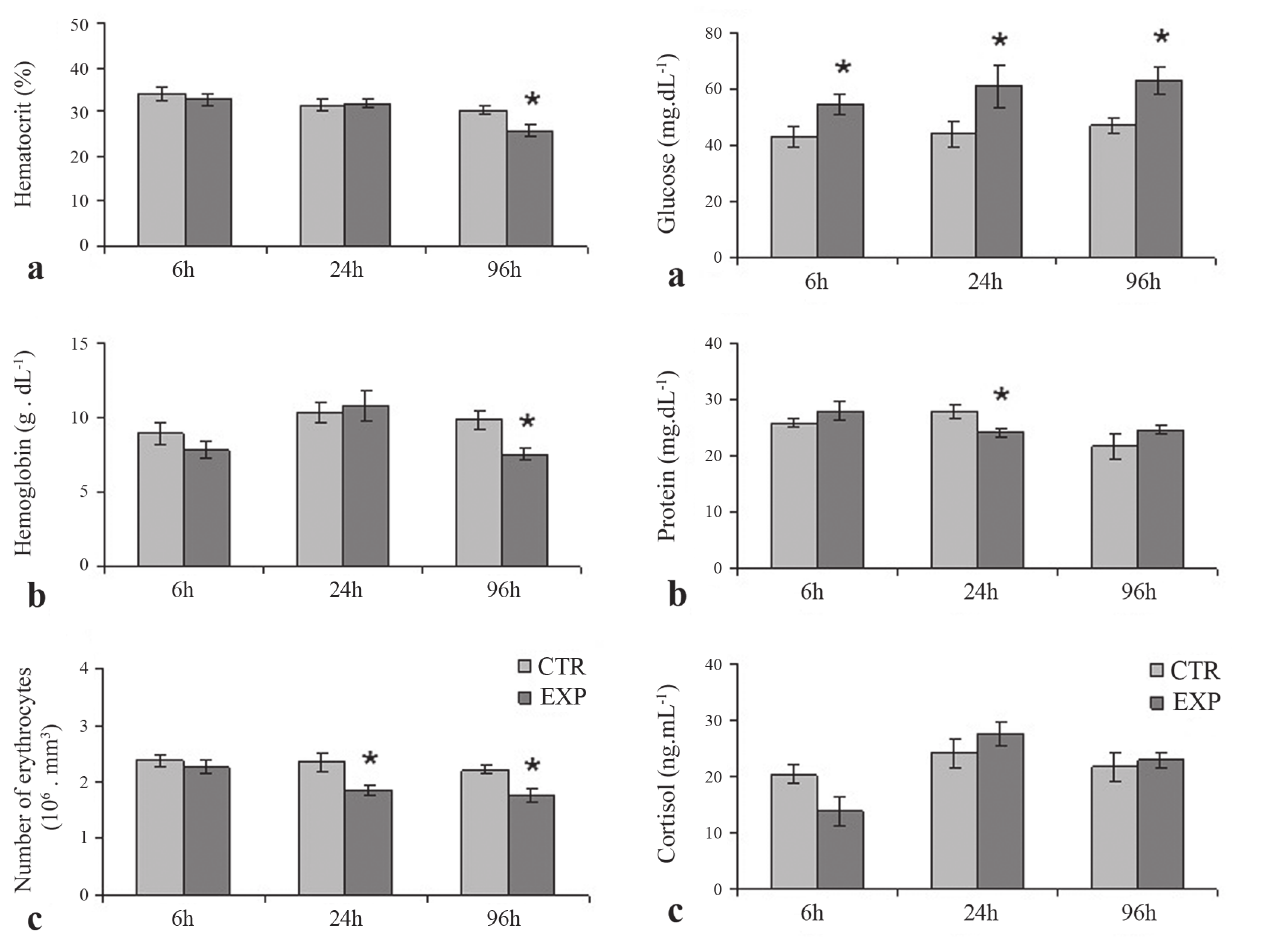
Fig. 1. Hematocrit ( a ), hemoglobin ( b ) and number of erythrocytes ( c ) in Prochilodus lineatus exposed to WSFG (EXP) or only to water (CTR) for 6, 24 and 96h. Data are means ± SEM (n = 10-13), asterisks indicate different from respective control (P < 0.05).